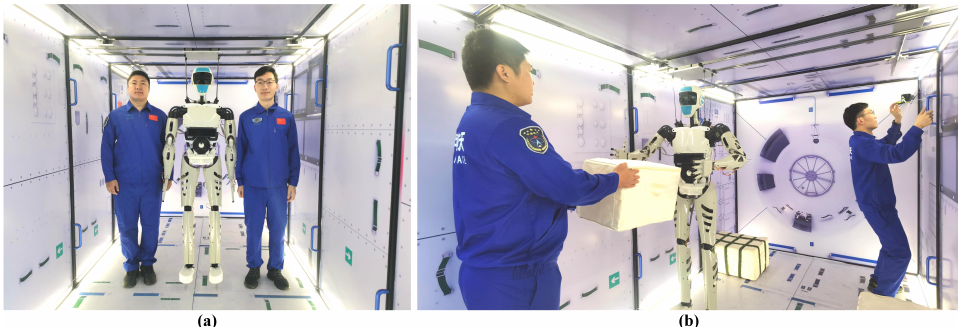
Figure 1. The robotic intravehicular assistant, Taikobot. ( a ) Taikobot is suspended in a space station mock-up. ( b ) A scenario where Taikobot helps astronauts transport cargoes with a dual arm system.